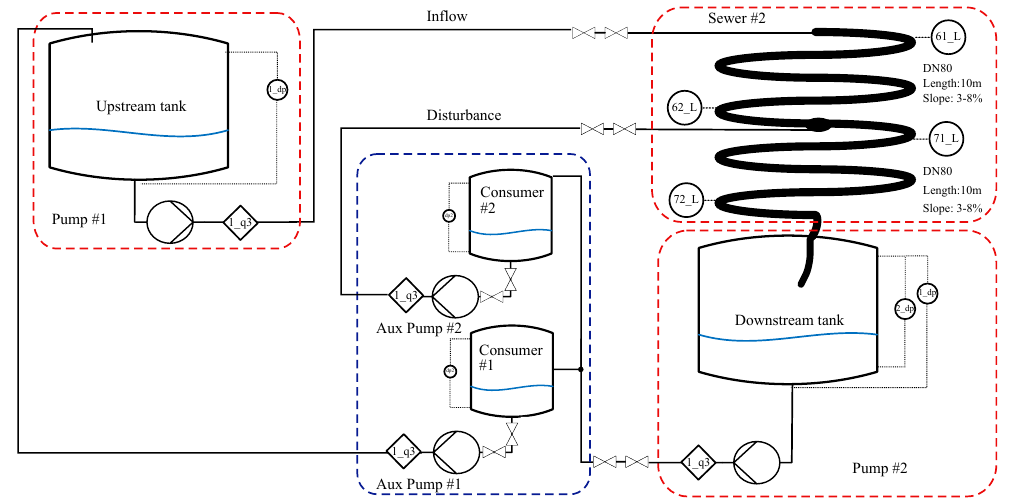
Figure 21. Diagram of the Ishøj emulated waste water collection at the